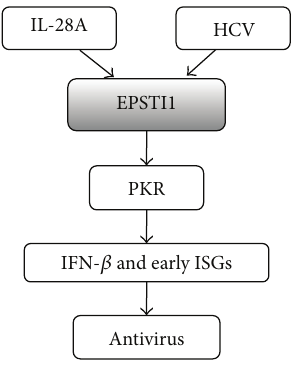
Figure 8: Model for EPSTI1-mediated anti-HCV activity. EPSTI1 induced by IL-28A and HCV infection can activate PKR expression, which leads to the induction of PKR-dependent genes, including IFN- 𝛽 and some early ISGs, to restrict HCV